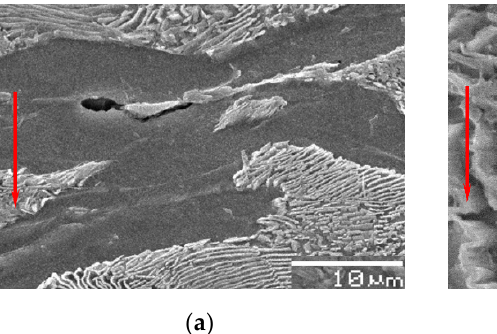
Figure 8. Microstructural damage for strain level ε z2 = 0.75: ( a ) propagation of microcracks in pearlite colonies; ( b ) nucleation of microvoids at the junction of three ferrite grains (red arrow—direction of upsetting).